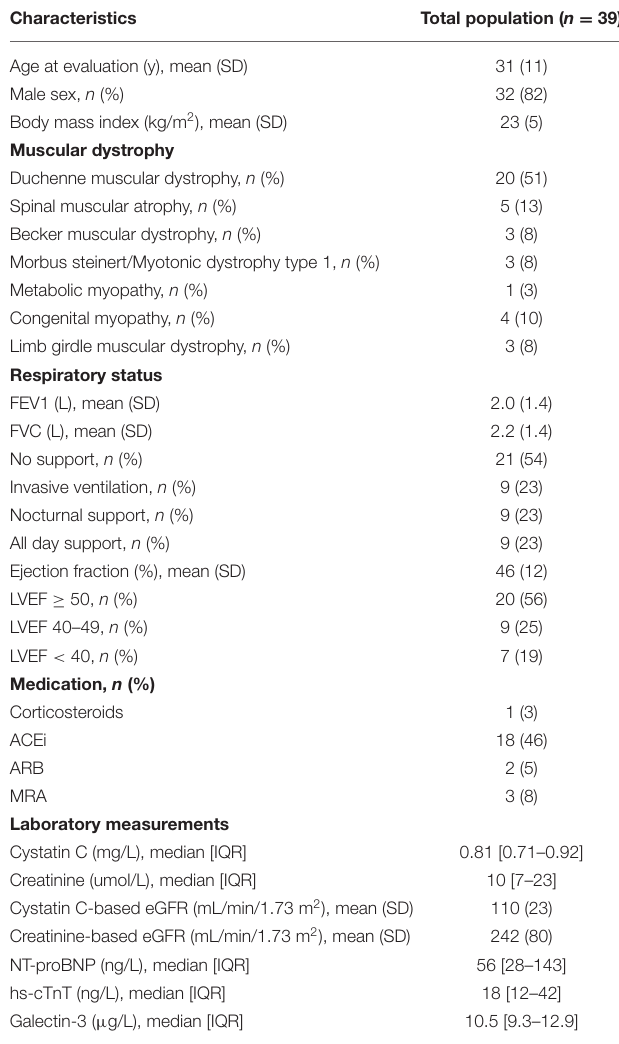
TABLE 1 | Baseline characteristics of neuromuscular dystrophy patients.